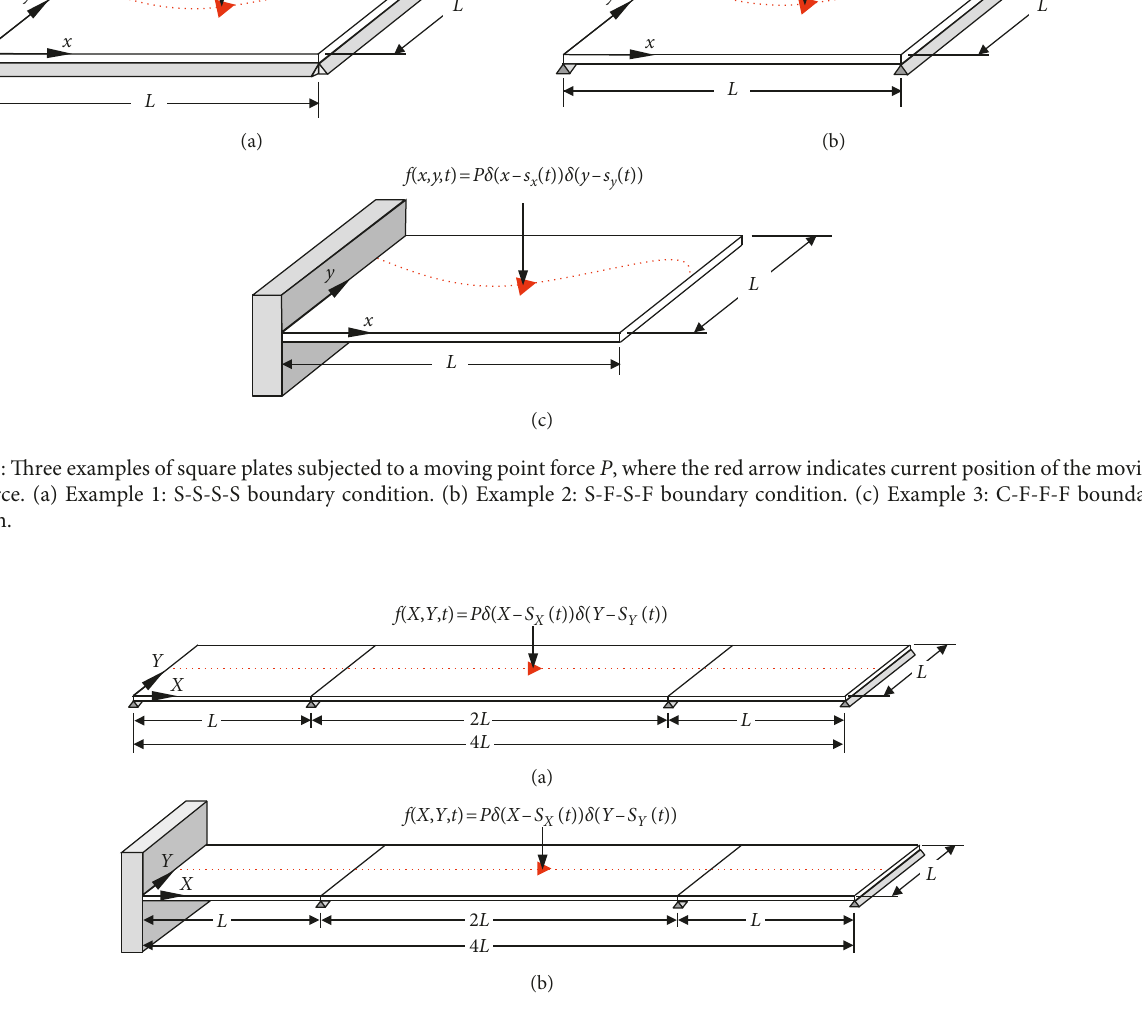
Figure 10: Two examples of three-span rectangular plates subjected to a moving point force P , where the red arrow indicates current position of the moving point force. (a) Example 4: S-S-S-S supports. (b) Example 5: C-S-S-S supports.